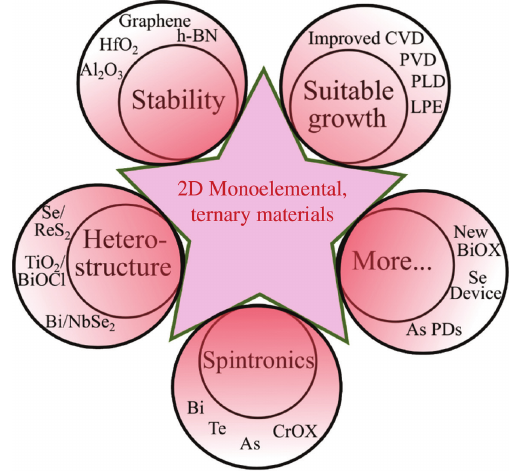
Figure 8: Summary of the novel 2D monoelemental, ternary materials in this